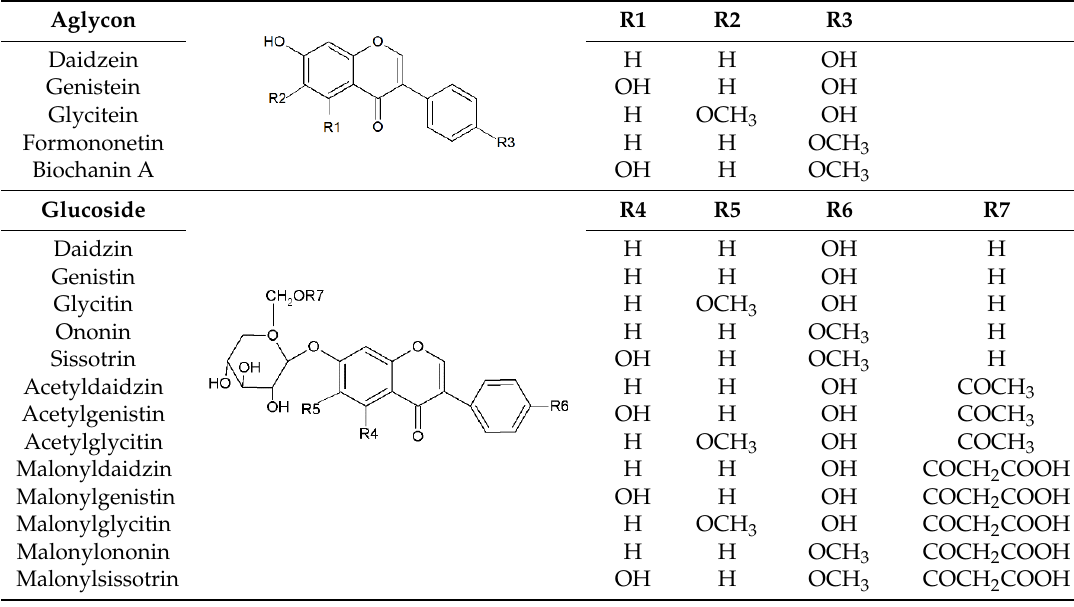
Table 1. The structure of isoflavones and their glycosides [24,25].